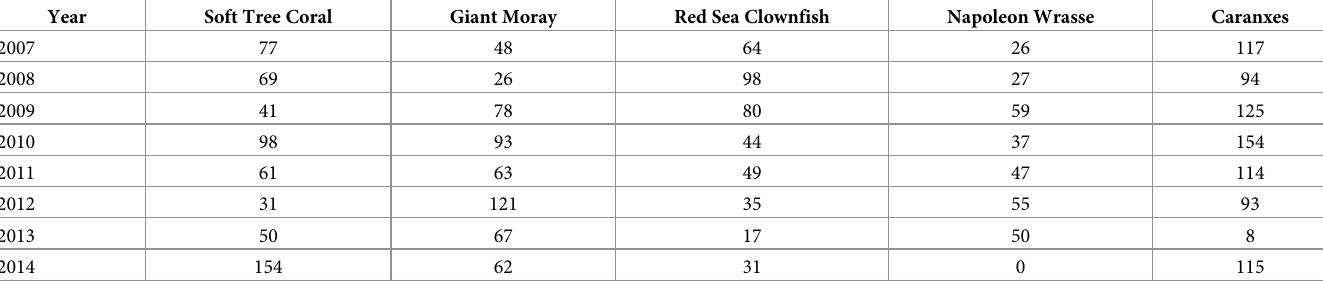
Table 3. Yearly relative abundance values of BVSTEP best species subset from centroid aggregated taxa abundance data. Year